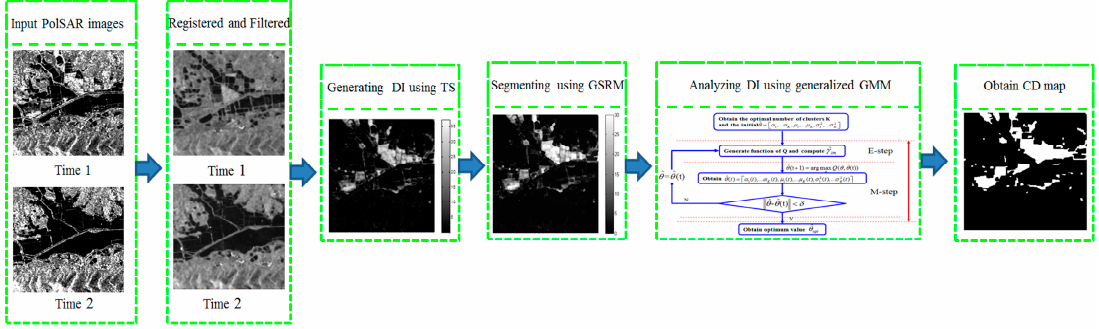
Figure 3. The process flow of the proposed method.